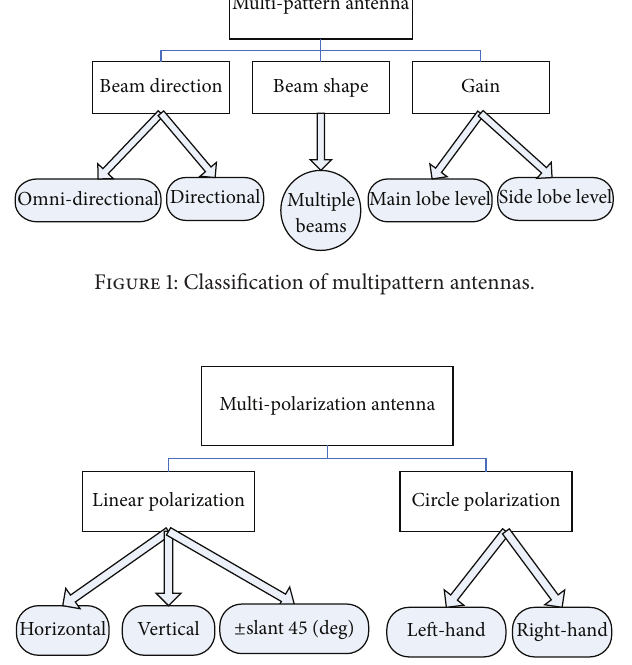
Figure 2: Classification of multipolarization